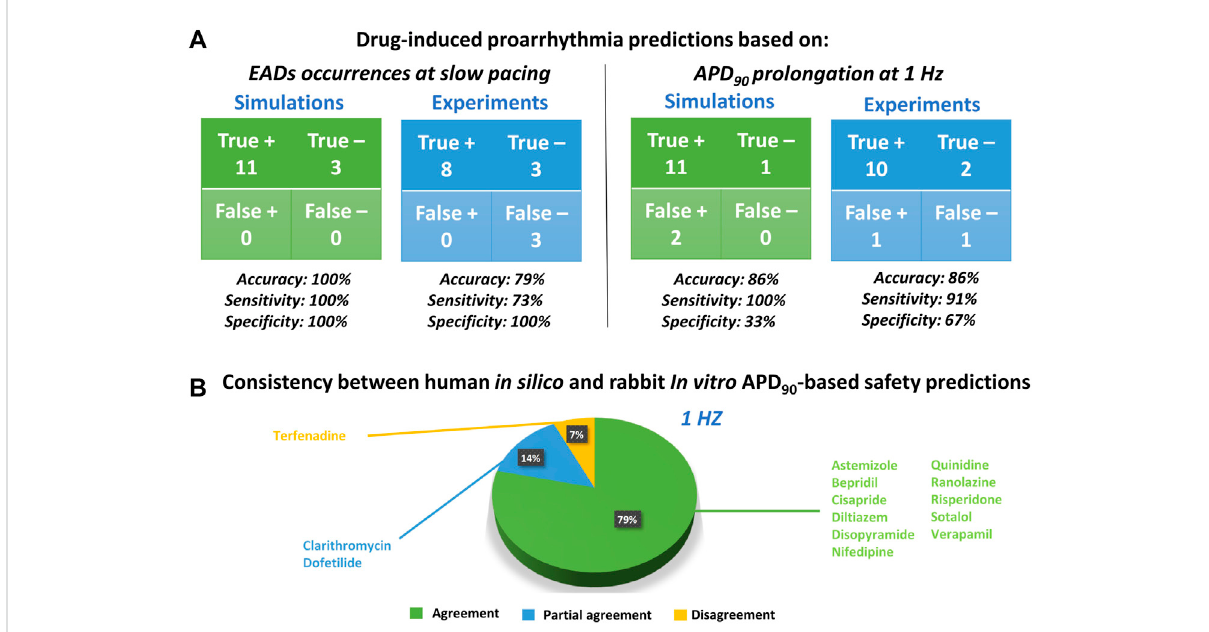
FIGURE 4 Proarrhythmic risk predictions using in silico human or in vitro rabbit models. (A) Confusion matrix for in silico (green) and in vitro (blue) predictions, compared to clinical report of proarrhythmia, based on EADs occurrences (left panel) or APD 90 (right panel); +: Risky drug; -: Safe drug. (B) Consistency between in silico and in vitro drug safety predictions based on APD 90 prolongation at 1 Hz. The pie chart represents the percentage ofcompoundsshowingagreementformostoftheconcentrationtested (green),partialagreementfor atleasthalfofthetestedconcentrations (blue), or disagreement